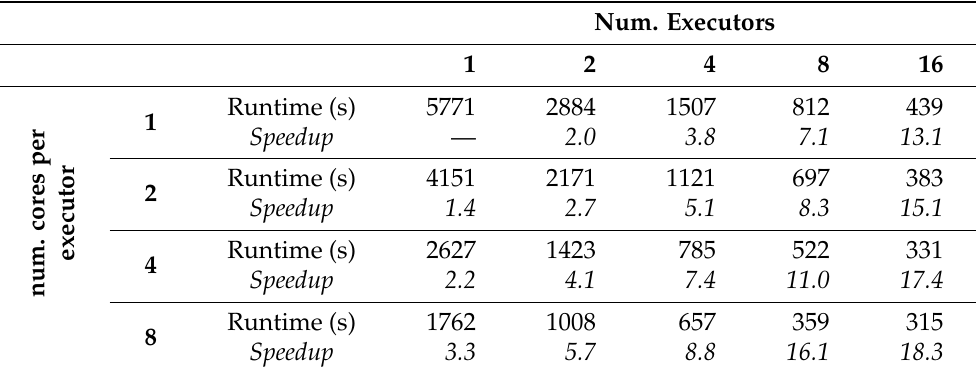
Table 2. Efficiency of the lower level of parallelization—Large